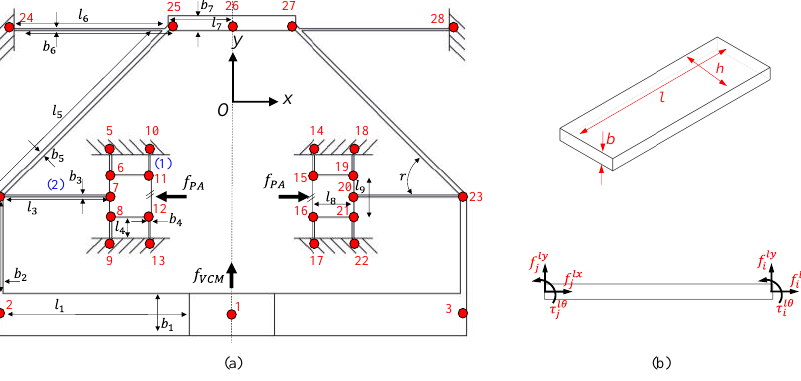
Figure 2. ( a ) Analytical model of ACPM, ( b ) schematic of flexible beam.